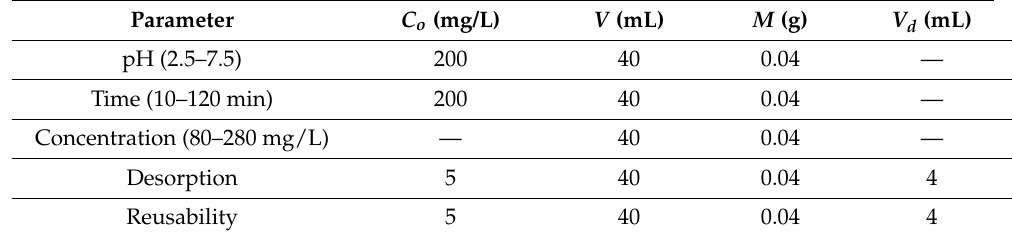
Table 1. Experimental conditions for the uptake of Cu(II) and Cd(II) ions using the F1 and F1S